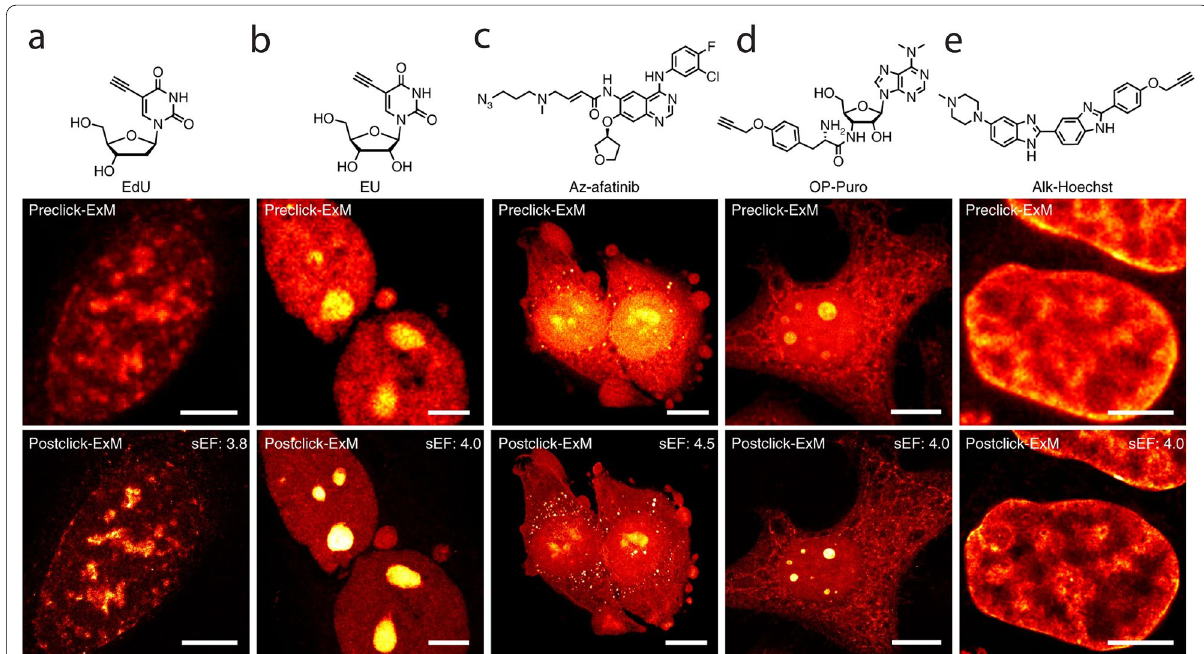
Fig. 12 Click-ExM imaging of proteins, nucleic acids and small molecules. a Chemical structure of EdU, and pre- and post-click-ExM images of nascent DNA (AF488) in EdU-treated HeLa cells. Scale bar, 5 μm. b Chemical structure of EU, and pre- and post-click-ExM images of nascent RNA (AF555) in EU-treated HeLa cells. Scale bar, 5 μm. c Chemical structure of Az-afatinib, and pre- and post-click-ExM images of HeLa cells treated with Az-afatinib (AF555). Scale bars, 10 μm. d Chemical structure of OP-Puro, and pre- and postc-lick-ExM images of nascent peptides (AF488) in OP-Puro-treated HeLa cells. Scale bar, 10 μm. e Chemical structure of Alk-Hoechst, and pre- and post-click-ExM images of DNA (AF488) in Alk-Hoechst-labeled HeLa cells. AcX was used for anchoring. Scale bar, 5 μm. All the scale bars are in the pre-expansion dimension. (Reprinted/ adapted by permission from Springer Nature: Sun et al. [66], copyright